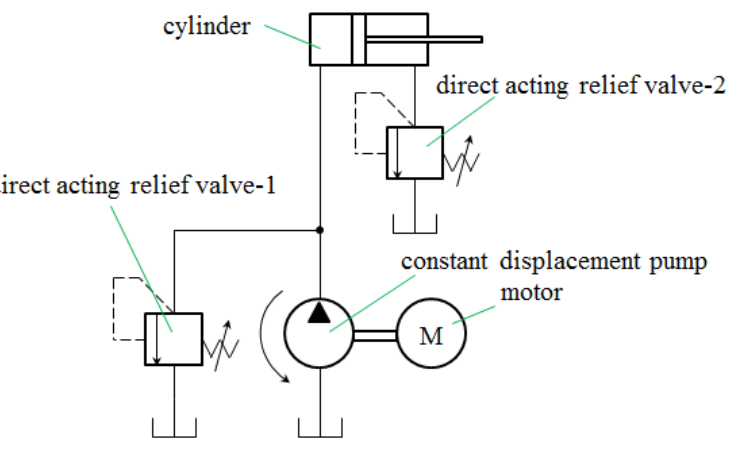
Figure 5. The back pressure generation circuit.